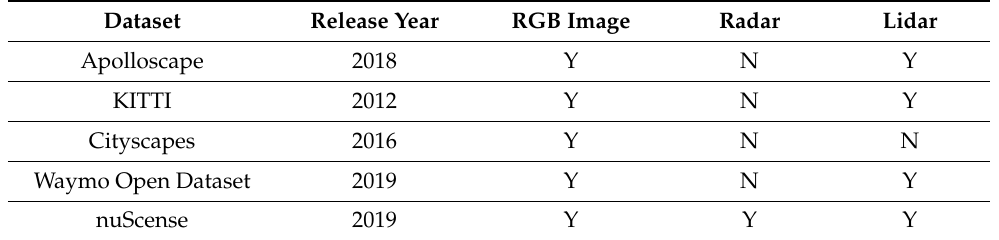
Table 1. Autonomous driving datasets. “Y” indicates the existence of the sensing information in this dataset and “N” indicates the absence of the sensing information in this dataset.